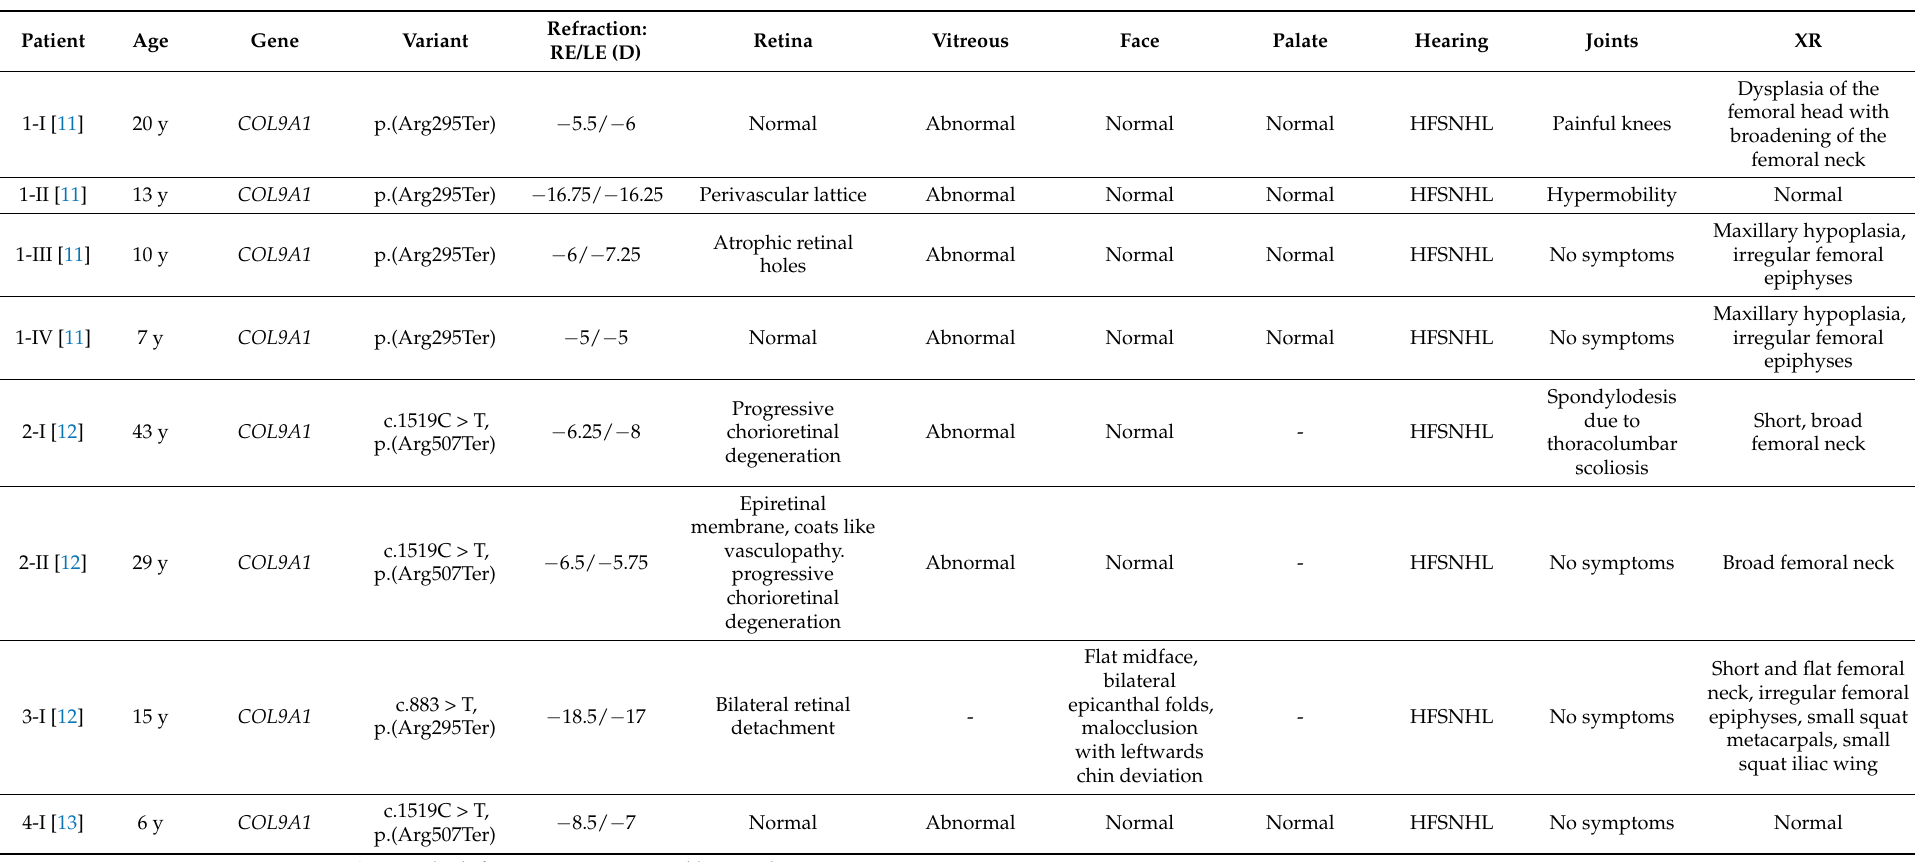
Table 1. Clinical features of patients with recessive pathogenic variants in COL9A1 . All variants mentioned are homozygous in the affected